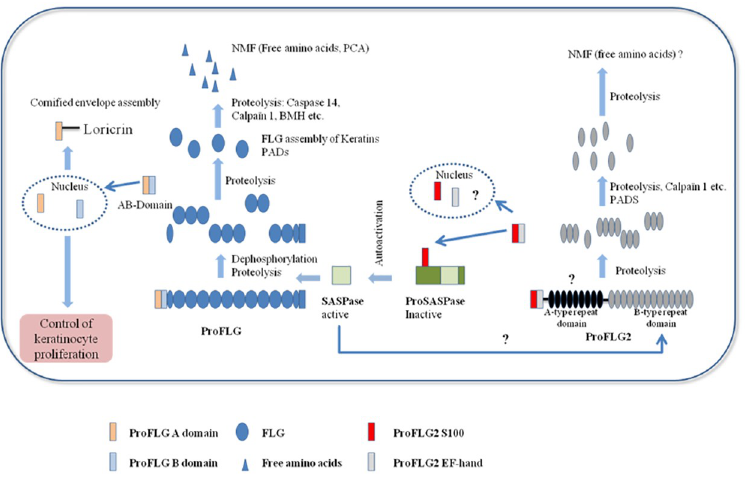
Fig 7. Proposed model for the role of FLG2Nter in the auto activation of SASPase and the maturation of FLG and FLG2.